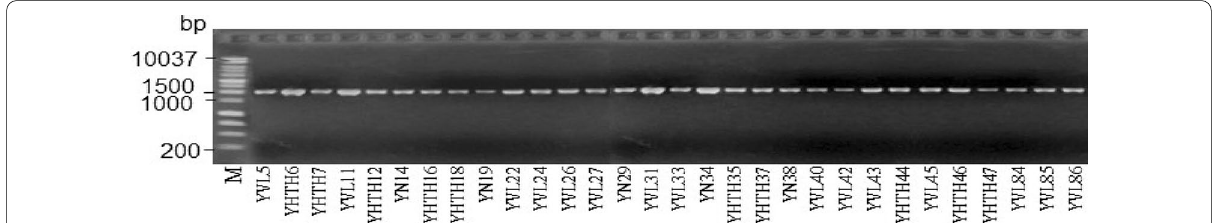
Fig. 2 Electrophoresis of PCR product. M: DNA mass scale (HyperLadder ™ 1 kb (200 bp to 10,037 bp), Bioline, Meridian Bioscience